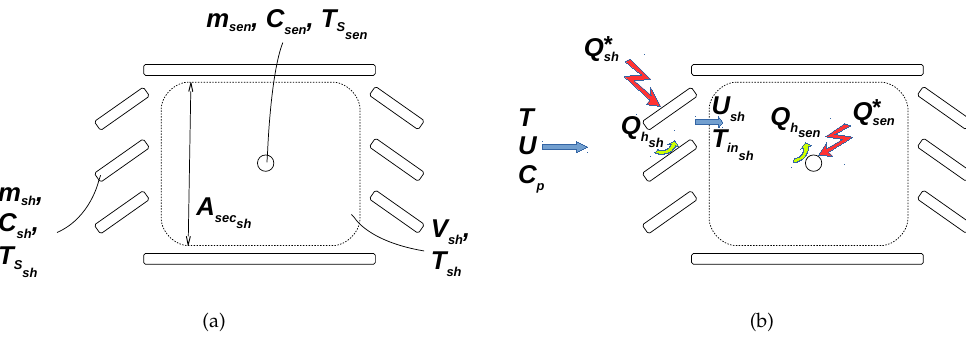
Figure 1. Cross-section view of a generic naturally ventilated shelter with ( a ) its main physical characteristics and ( b ) the main interactions with its